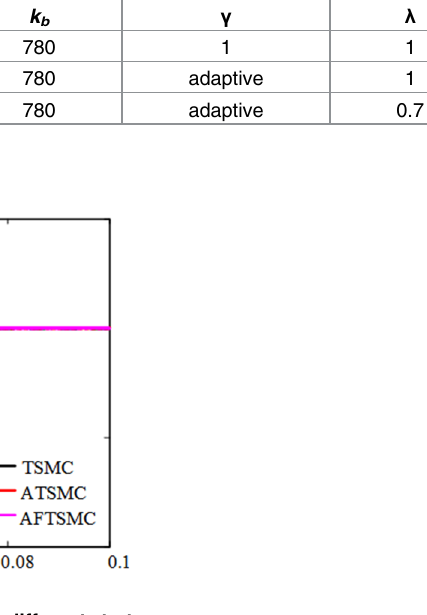
Fig 5. The output voltage dynamic response with different